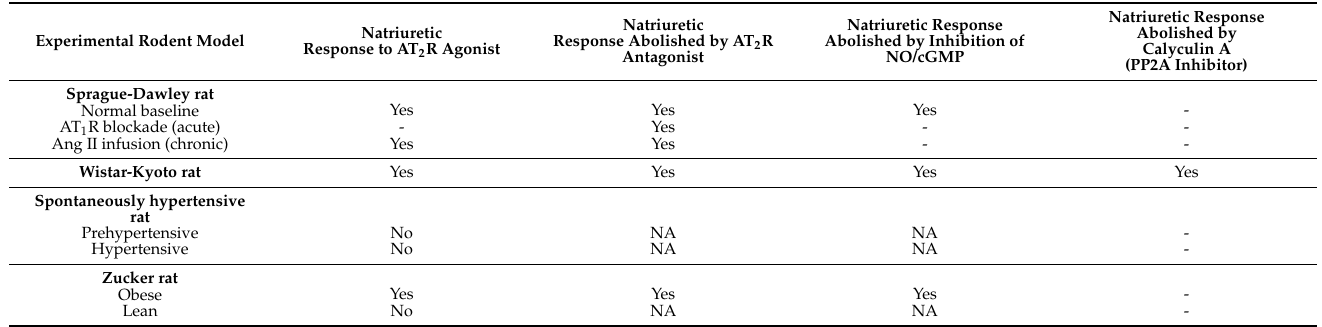
Table 1. Summary of AT 2 R-mediated Natriuretic Responses in Experimental Animal